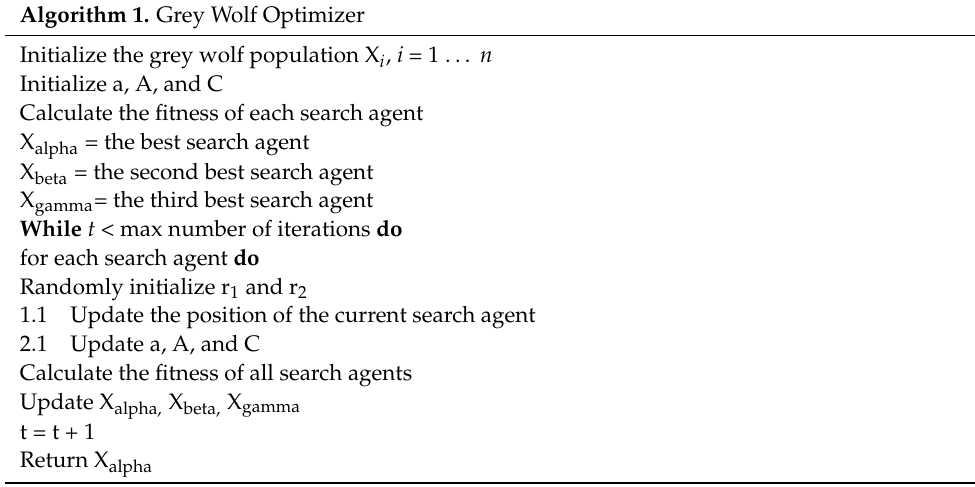
Algorithm 1. Grey Wolf